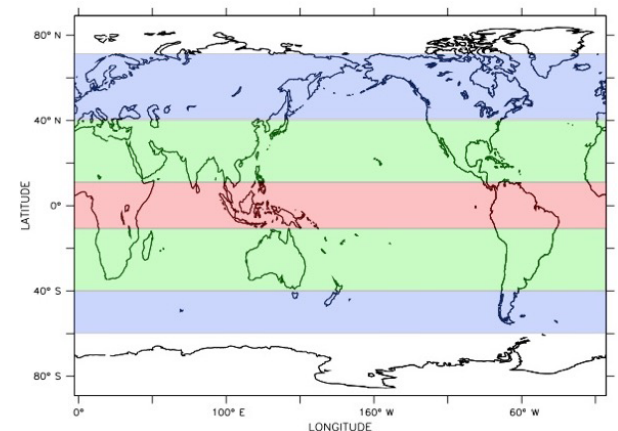
Figure 1. Ocean regions used for alkalinity injection in the period 2020–2100. Blue denotes the subpolar regions (AOA_SP), green regions represent the subtropical gyres (AOA_ST), the red area rep- resents the tropical ocean (AOA_ T), and all coloured regions com- bined the global alkalinity injection (AOA_ G). Note that the ocean regions not coloured represent the seasonal sea ice, where no alka- linity was added in the